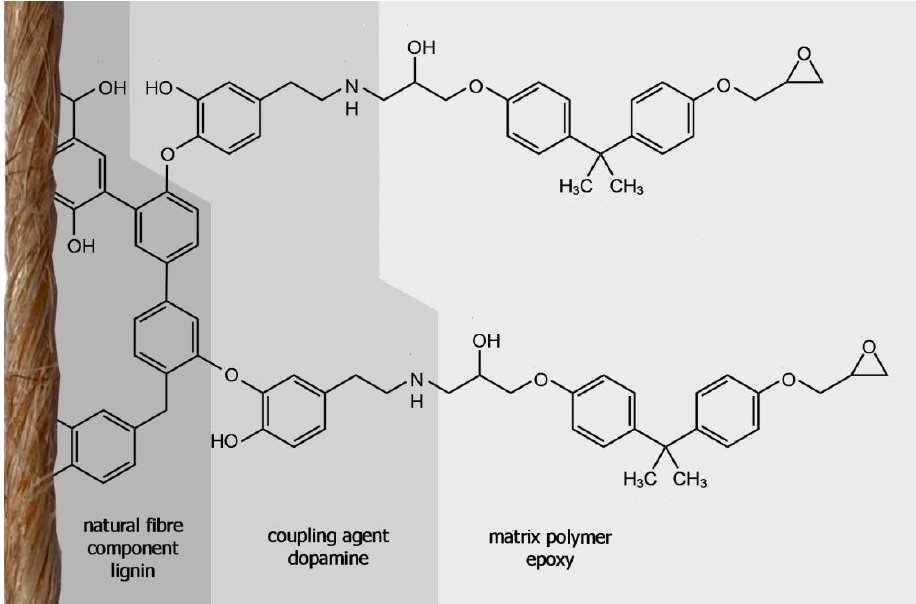
Figure 9. Presumed chemical structure between flax fibre lignin and epoxy matrix polymer by laccase-induced coupling of dopamine.